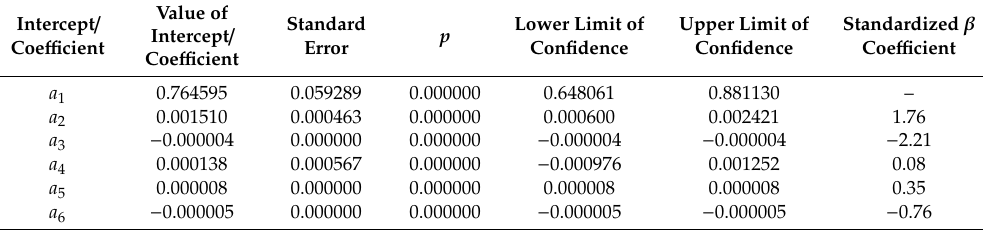
Figure 6. Visualization of 3D model of organic matter ( OM ) content of torrefied pruned biomass. Table 4. Statistical evaluation of organic matter ( OM ) content model torrefied of pruned biomass.